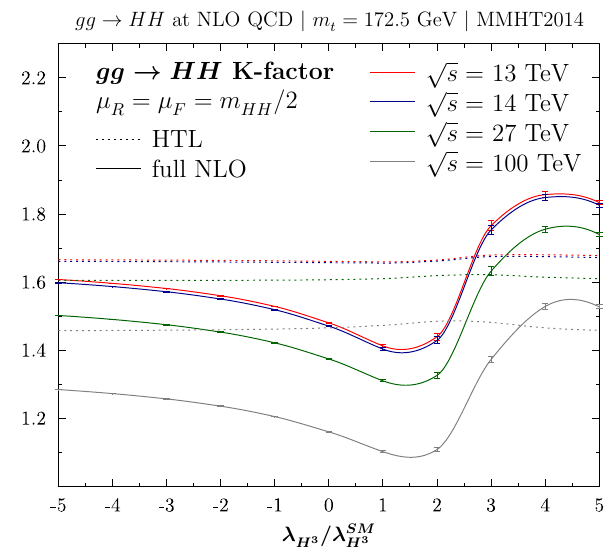
Figure 18 . K-factors of Higgs-pair production at NLO as functions of the trilinear self-coupling (cid:21) H 3 in units of the SM value (cid:21) SM for various c.m. energies of 13 TeV (red curves), 14 TeV (blue curves), H 3 27 TeV (green curves) and 100 TeV (grey curves). The full NLO result is presented by the full curves with the error bars indicating our numerical errors. The dotted curves show the corresponding K- factors of the Born-improved HTL. MMHT2014 PDFs have been used and the renormalization and factorization scales of (cid:11) s and the PDFs have been (cid:12)xed at our central scale choice (cid:22) R = (cid:22) F = Q= 2 = m HH =